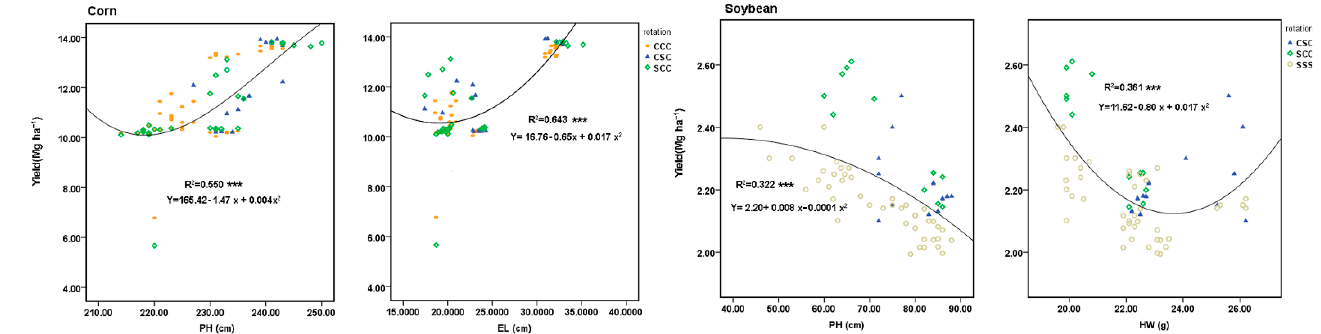
Figure 2. Relationship between yield and plant height (PH) or length of corn ear (LE) for corn. Relationship between yield and plant height (PH) or hundred grain weight (HW) for soybean. Different lowercase letters indicate significant differences at p < 0.05 using Fisher’s least signifi- cant difference.